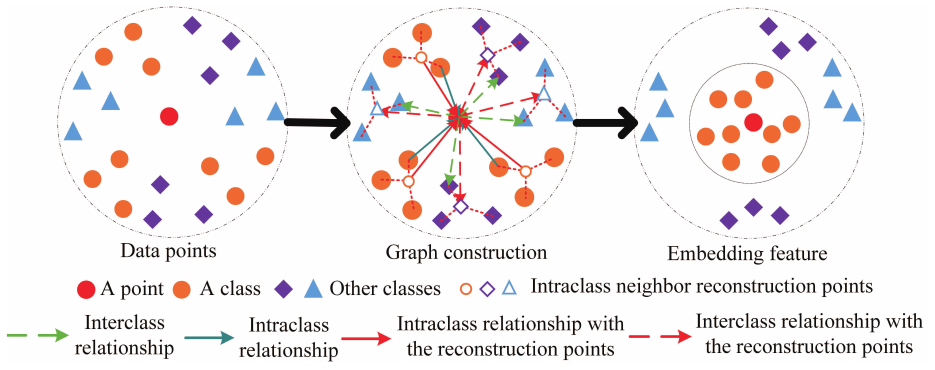
Figure 3. An example for the processing of